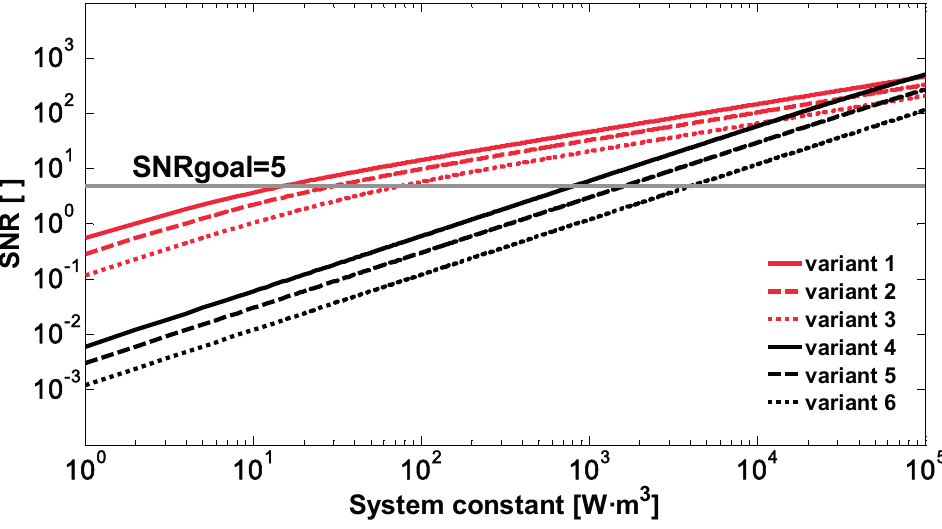
Figure 2. Signal-to-noise ratio vs. system constant due to a spray drift cloud located at 500 m for variants 1 to 6 (Table